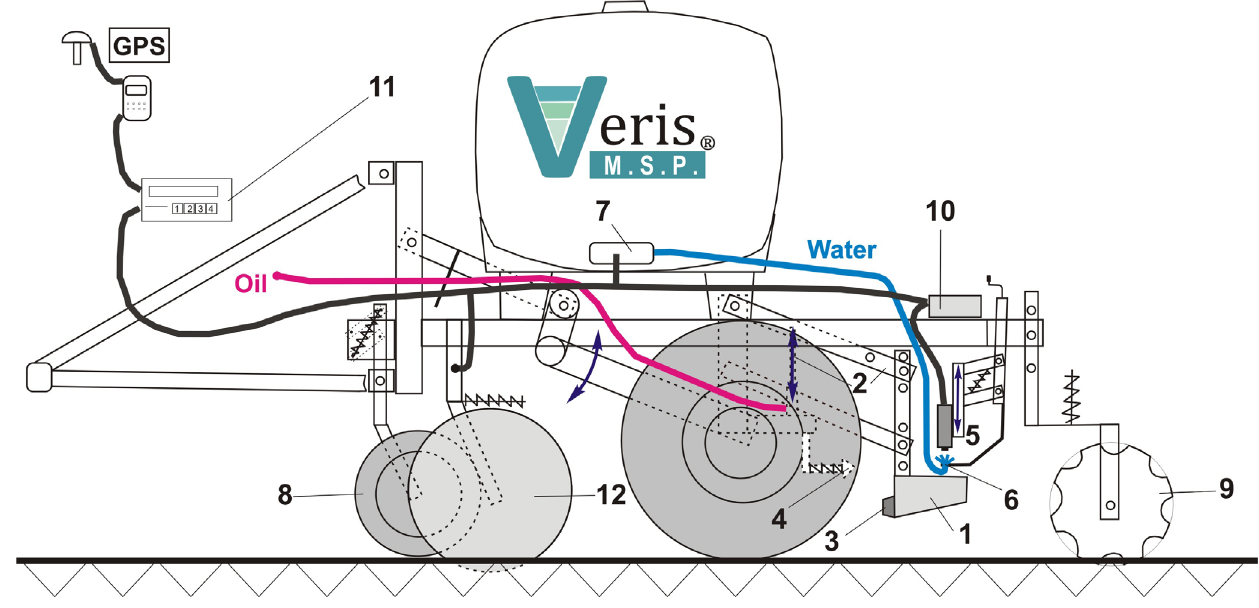
Figure 2. Schematic of the Veris Multi Sensor Platform (MSP) including the Soil pH Manager and the Soil Electrical Conductivity Surveyor. Numbers are explained in the